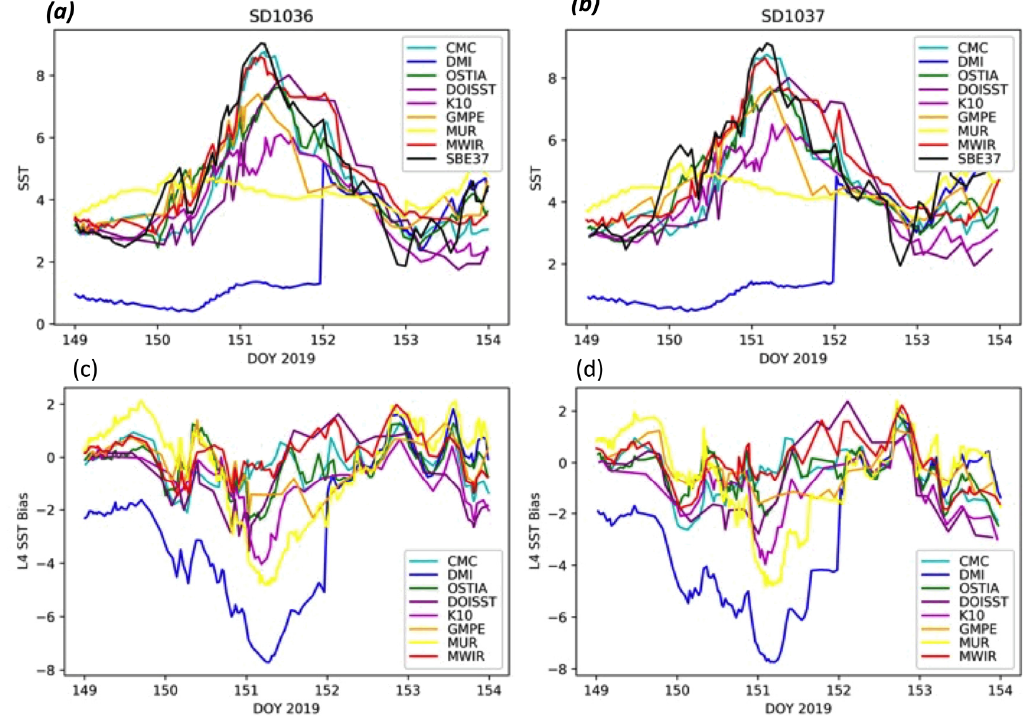
Figure 3. ( a – d ) SST amplitudes (top ( a , b )) and L4 biases, relative to the SBE37 SSTs (bottom, ( c , d )), while the saildrones were traversing the Y–K delta on 31 May 2019 (DOY 151). The left column is for SD1036, and the right is for SD1037.